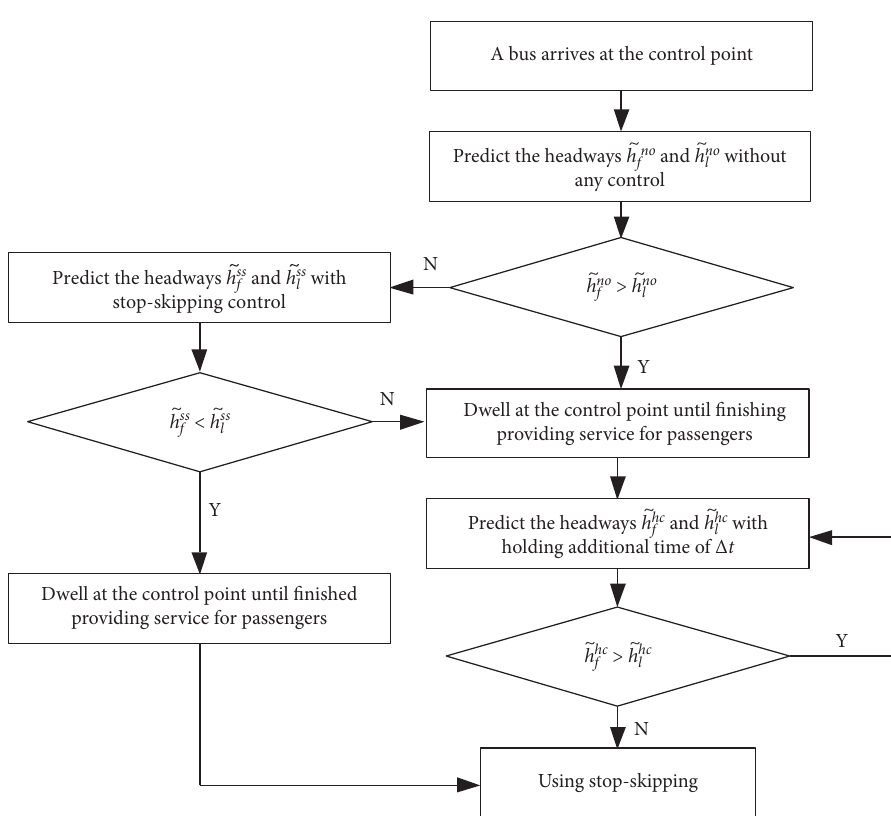
Figure 2: Control procedure for buses at